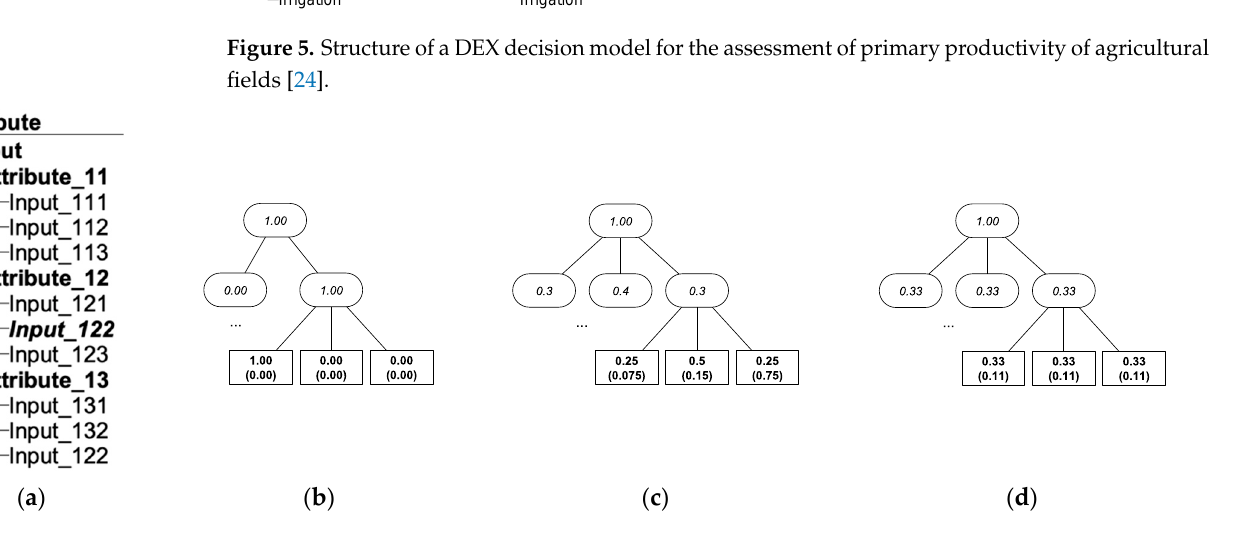
Figure 6. Examples of the structure and weight distributions of a benchmark DEX decision model. ( a ) The hierarchical structure of a benchmark DEX model with a depth of 3 levels and one linked attribute (Input_122); ( b – d ) examples of skewed ( b ), normal ( c ), and uniform ( d ) distributions of aggregation weights [26].